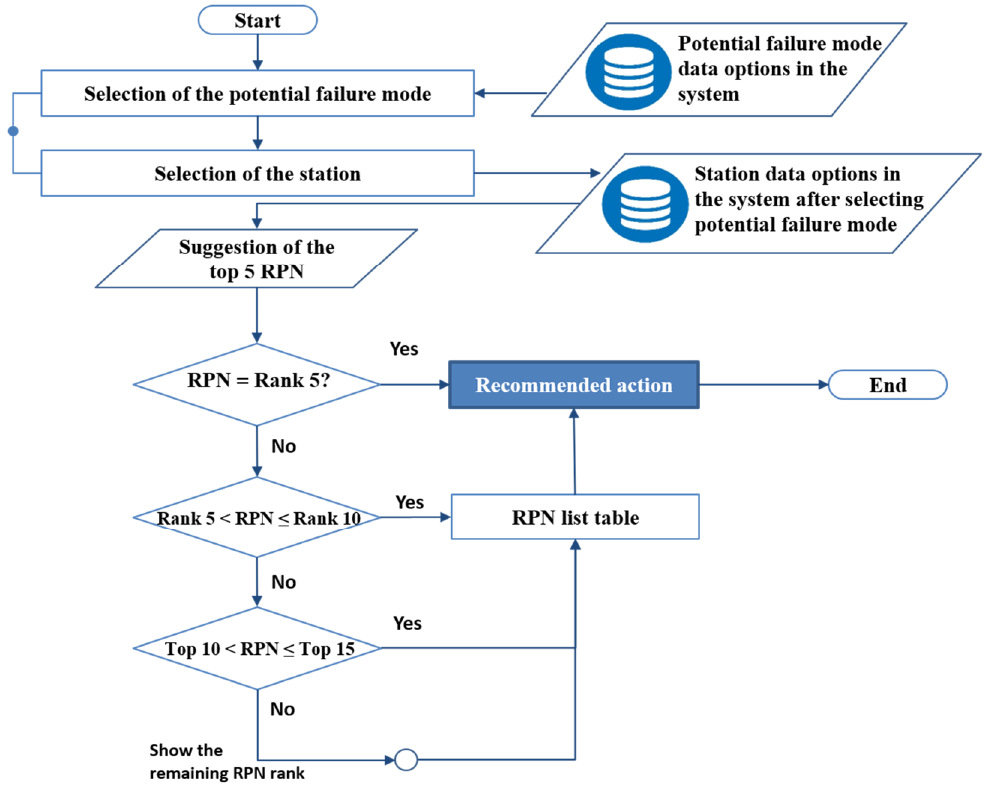
Figure 5. Rule-based Algorithm for DFMEA.